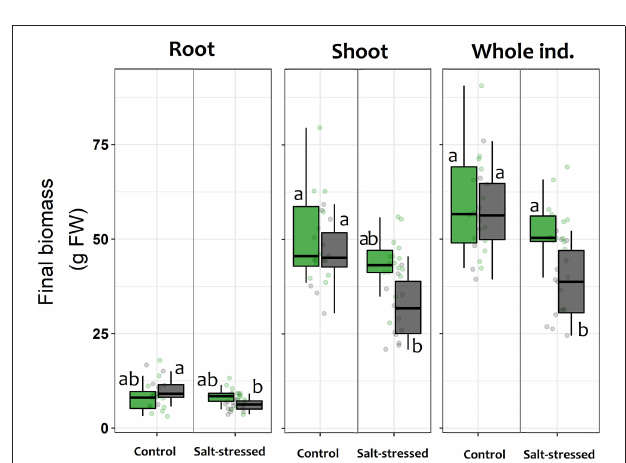
FIGURE 5 | Final mean fresh biomass weight for roots, shoots and whole individuals of lettuce plants after being subjected for 60 days to saline stress (200mM NaCl for “stressed” individuals) and inoculated with the Antarctic microbial consortium (S + plants). Control groups for both conditions (non-stressed and non-inoculated, S–) are also shown. The box-plot represents the interquartile distribution of the data for each experimental group. Different letters indicate significant a posteriori differences (Tukey test, α <